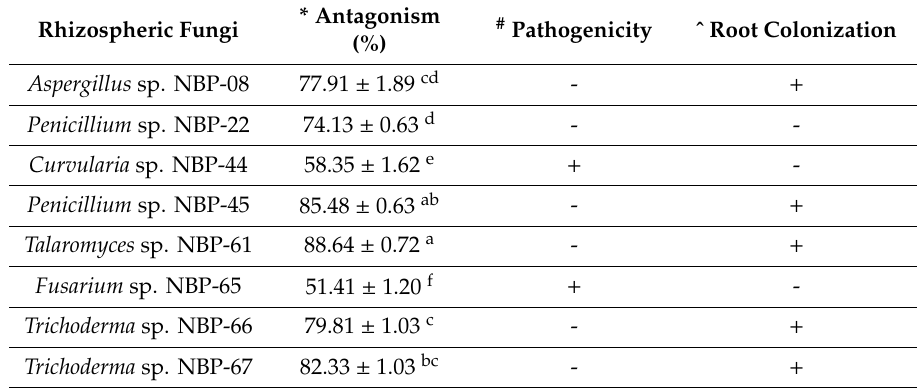
Table 1. In vitro antagonism, pathogenicity and root colonization ability of rhizosphere